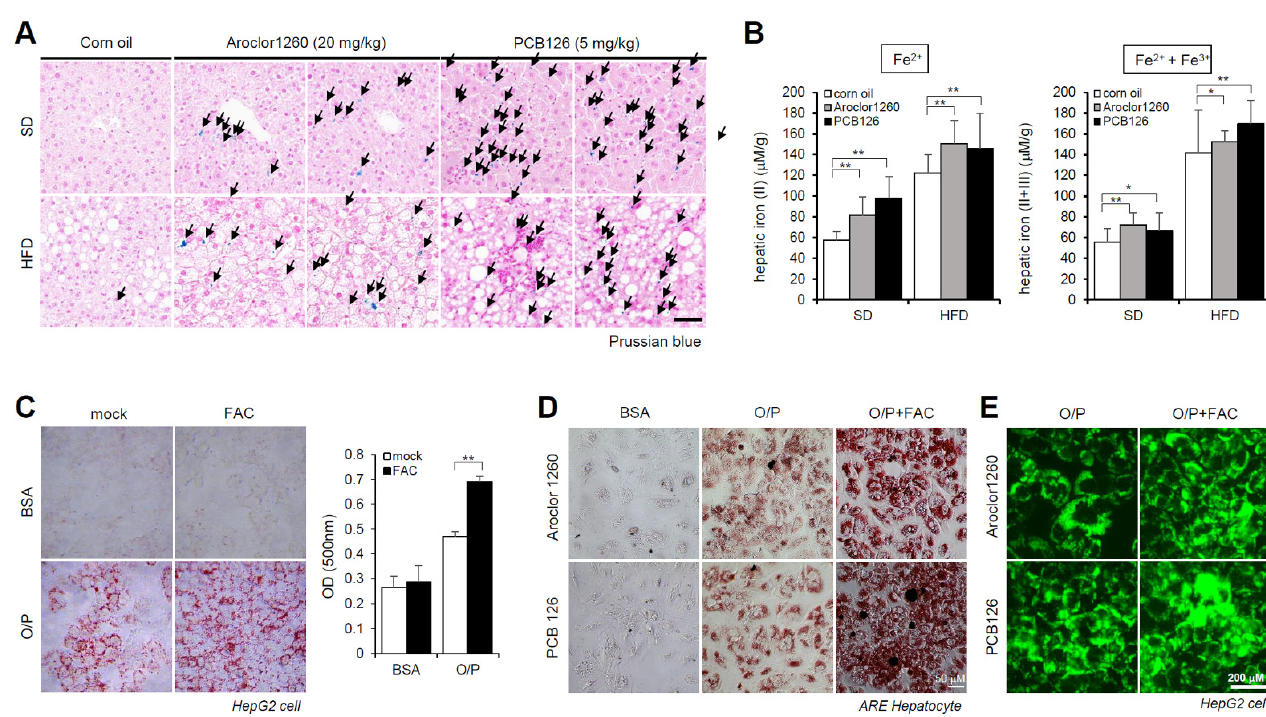
Figure 2. PCB exposure induces hepatic iron overload, and excess iron causes lipid accumulation. ( A ) Prussian blue staining showing marked iron accumulation in liver samples from Aroclor1260- or PCB126 (5 mg/kg)-injected mice fed either a SD or HFD. Scale bar: 50 μ m. ( B ) Hepatic iron levels in Aroclor1260- or PCB126-injected mice fed either a SD or HFD (left panel, ferrous ion level; right panel, ferrous and ferric iron total levels). All values represent the mean ± SD, n = six to nine mice per group. * p < 0.05 and ** p < 0.01. ( C ) ORO staining and quantification showing that 200 μ M FAC treatment augments O/P-induced lipid accumulation in HepG2 cells. All values represent the mean ± SD, n = 3. **, p < 0.01 compared with the experimental control. ( D ) ORO staining showing that 200 μ M FAC accelerated the hepatic lipid accumulation induced by both 20 μ M Aroclor1260 and 10 μ M PCB126 in O/P-treated human ARE primary hepatocytes. Scale bar: 50 μ m. ( E ) BODIPY 493/503 staining showing that 200 μ M FAC accelerated the hepatic lipid accumulation induced by both 20 μ M Aroclor1260 and 10 μ M PCB126 in O/P-treated HepG2 cells. Scale bar: 200 μ m.